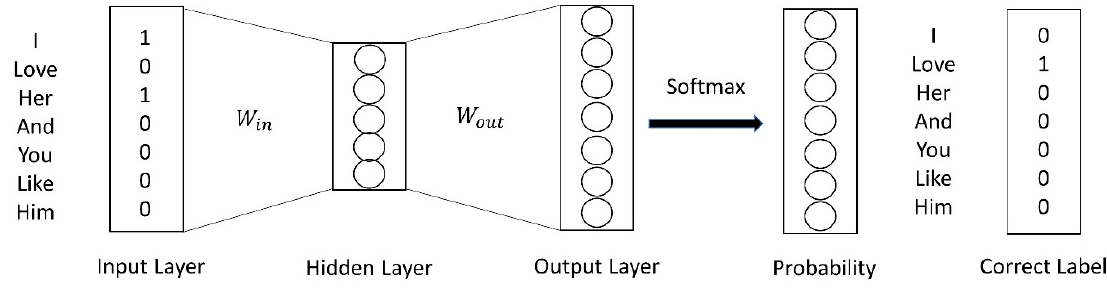
Figure 2. Figure 2. word2vec.